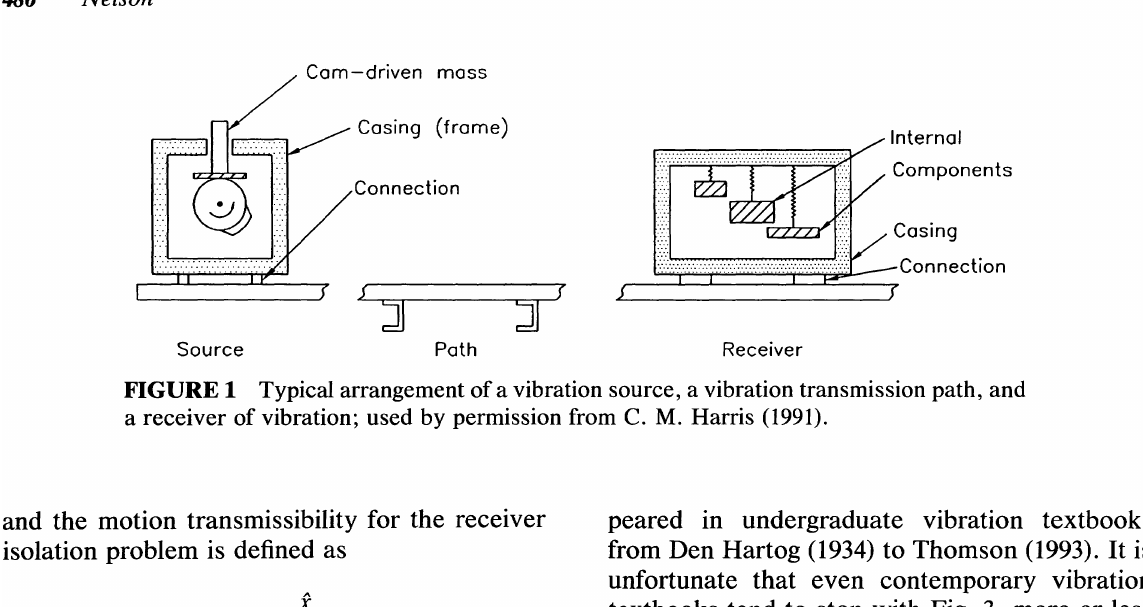
FIGURE 1 Typical arrangement ofa vibration source, a vibration transmission path, and a receiver of vibration; used by permission from C. M. Harris (1991).